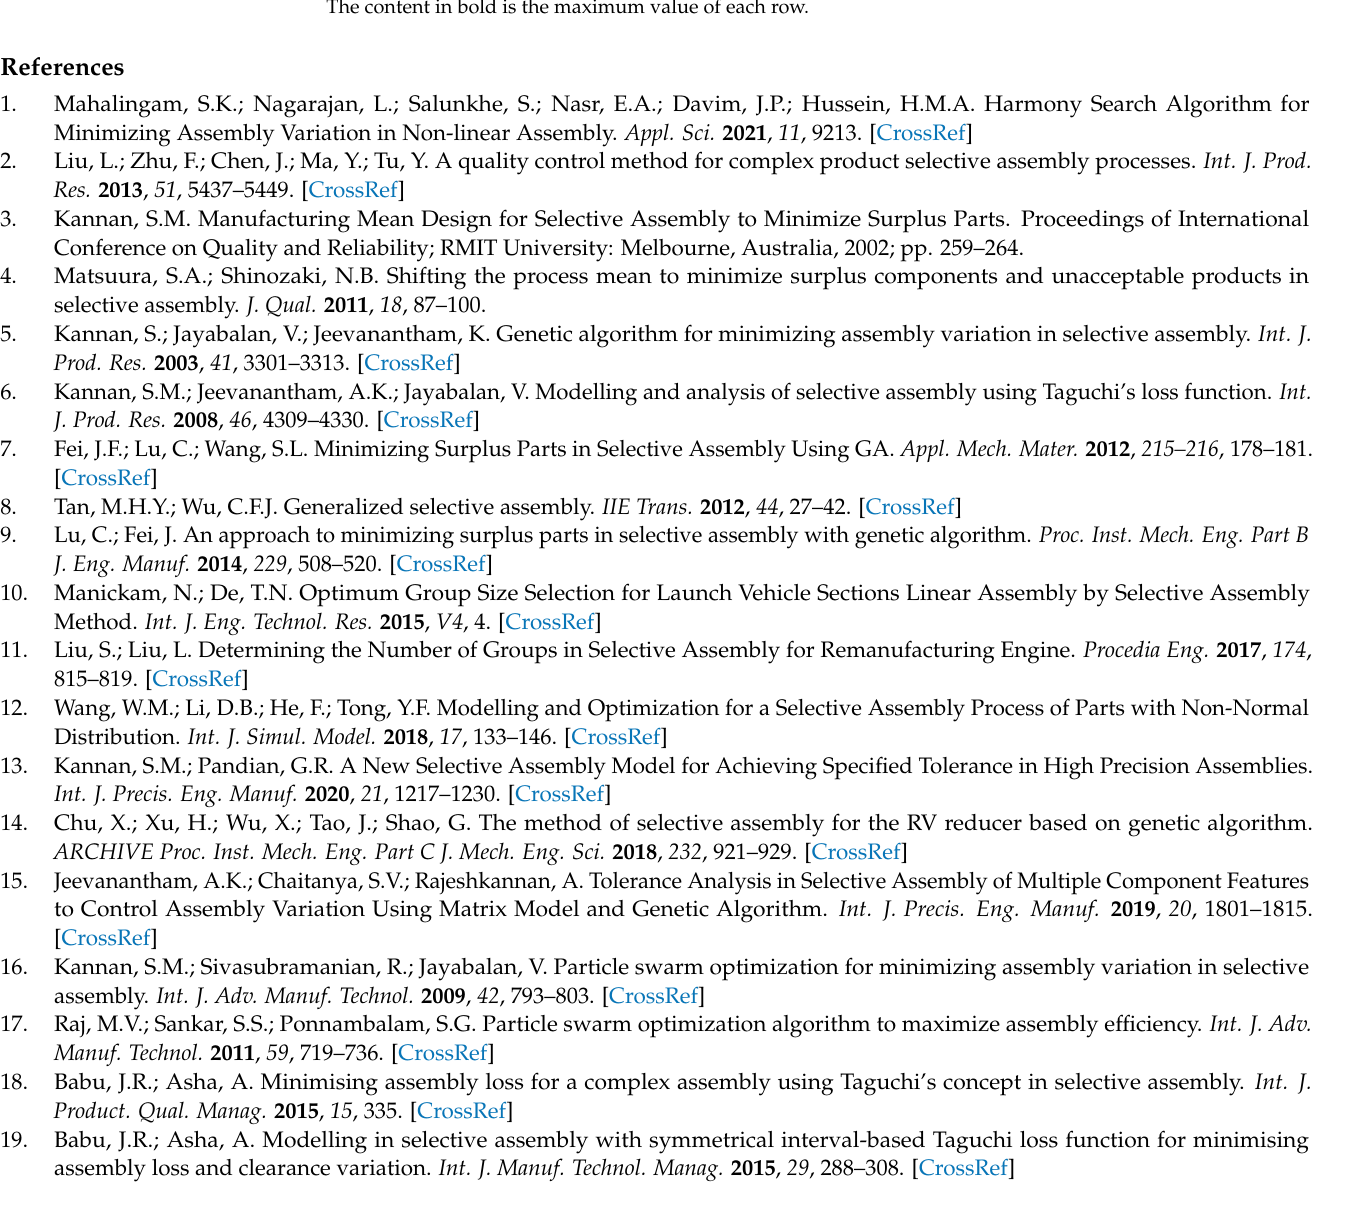
The content in bold is the maximum value of each